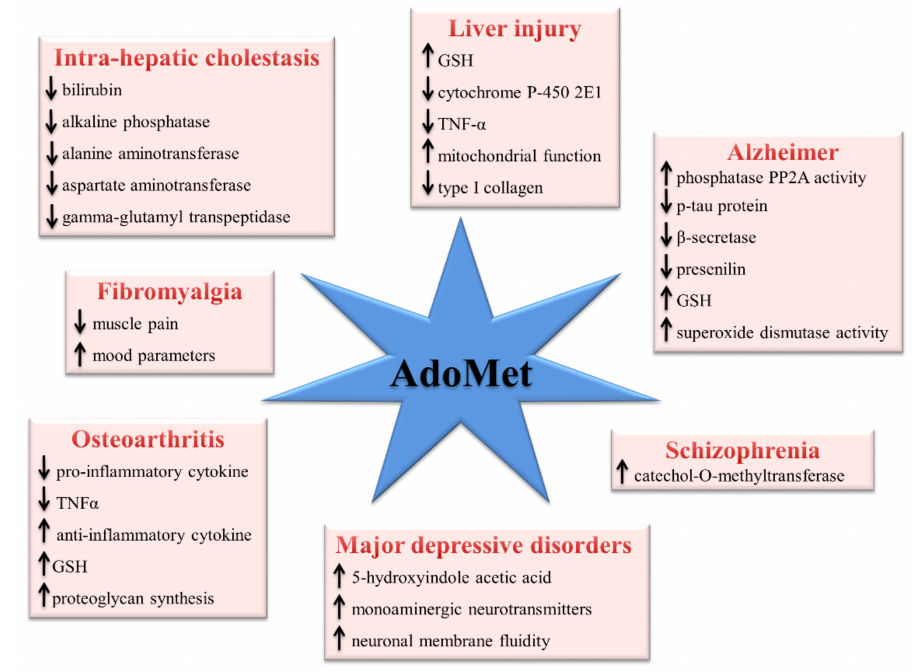
Figure 3. AdoMet’s ability to counteract the pathological hallmarks of many human diseases by different